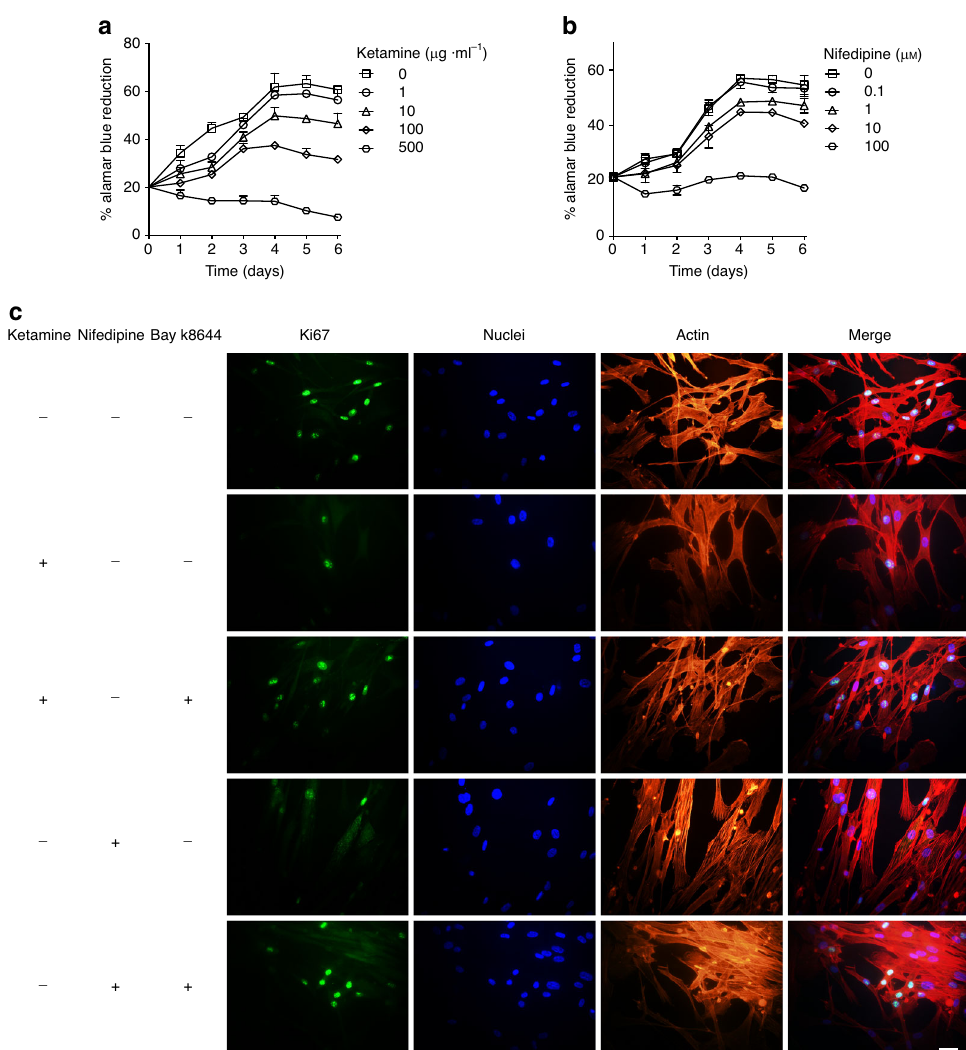
Fig. 7 Ketamine and nifedipine dose-dependently inhibit human BSM cell proliferation. Primary cultured human BSM cells were incubated with ketamine or nifedipine for 1 – 7 days at the indicated concentrations, cell proliferation was assessed by alamar blue assay in the presence of ketamine ( a n = 4) or nifedipine ( b n = 4). Ketamine and nifedipine inhibited hBSM cell proliferation. c Immuno fl uorescent staining of ki67 (green) in hBSM cells was inhibited by pretreatment with ketamine (100 µ g ml − 1 ) or nifedipine (10 µ M), but inhibition was rescued by 200 nM Bay k8644, representative images are from two independent experiments with at least three samples each group at each experiment. Scale bar: 40 µ m. Data are presented as mean values ± SD. Source data are provided as a Source Data fi